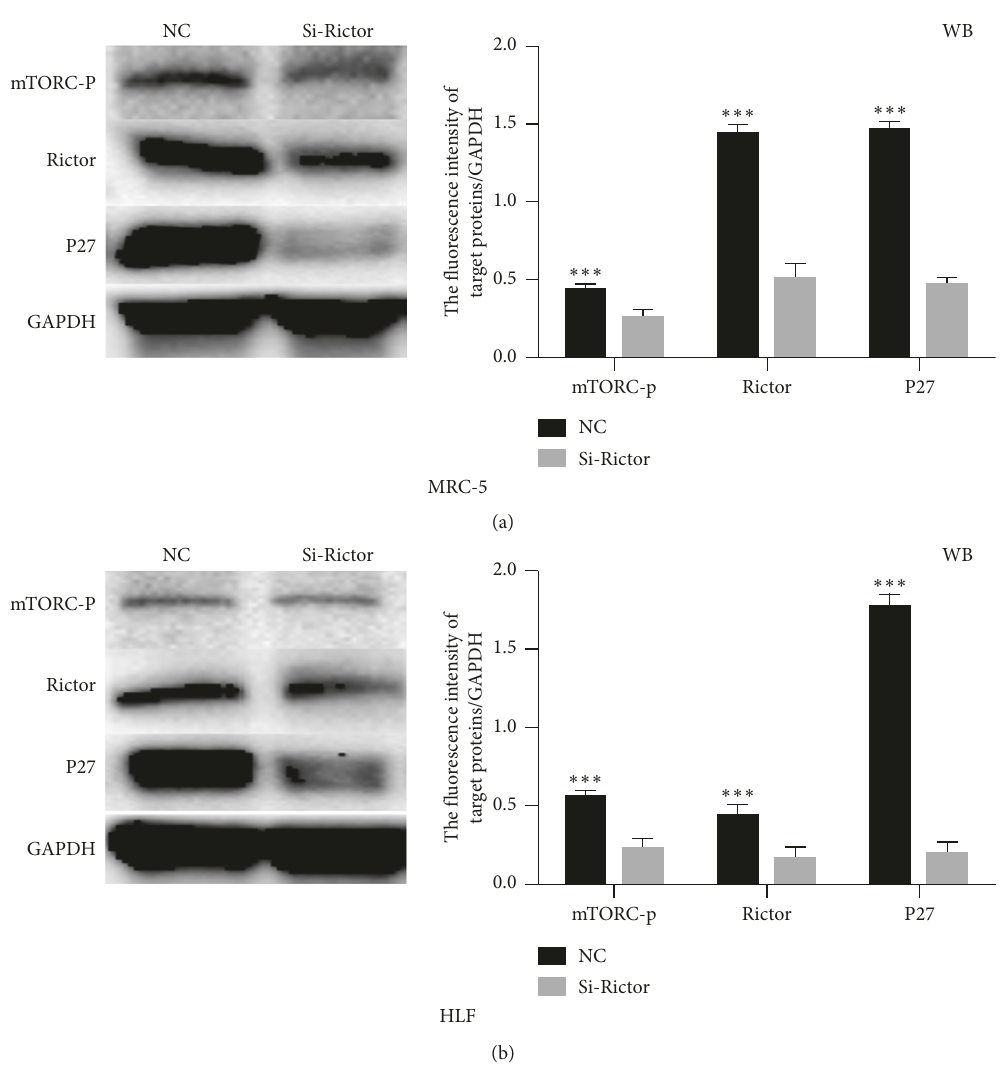
Figure 3: MTORC2 inhibition decreased the level of P27. (a, b) Western blot analysis of expression of mTORC-p, RICTOR, and P27 in MRC5 and HLF cells transfected with RICTOR